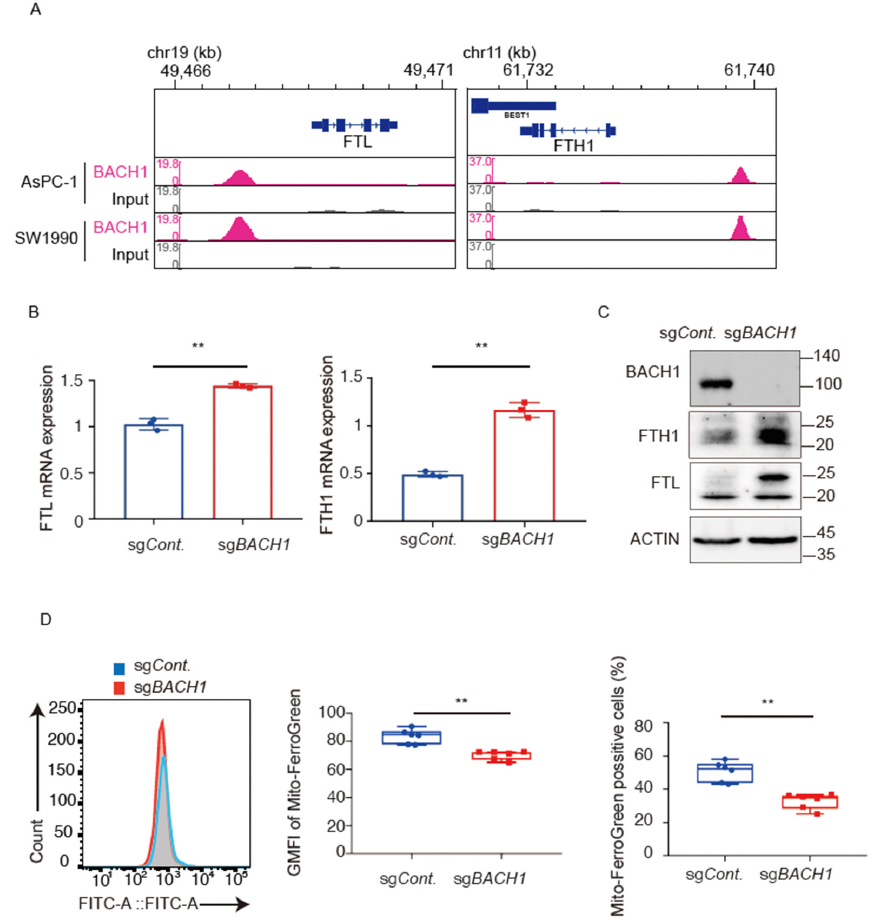
Figure 3. BACH1 increases the iron content by repressing the expression of ferritin. ( A ), ChIP-seq analysis of the binding of BACH1 to FTL and FTH1 genes in AsPC − 1 cells and SW1990 cells. ( B ), Relative mRNA levels of FTL and FTH1 in BACH1 knockout and control AsPC − 1 cells. All data are presented as mean ± SD, with p values from the Student’s t -test, n = 3 biologic replicates for each experiment. **, p < 0.01. ( C ), Western blotting of BACH1 and ferritin proteins as in ( B ). Cell lysates were used for anti-BACH1, anti-ferritin heavy, anti-ferritin light and anti-actin Western blotting. ( D ), Flow cytometry analysis for detecting mitochondrial Fe 2+ with Mito-FerroGreen in BACH1 knockout and control AsPC − 1 cells. Distribution (left), mean fluorescence intensity (middle) and the fraction of positive cells (right) are shown. GMFI, geometric mean fluorescent intensity. All data are presented as mean ± SD, with P values from the Student’s t -test. n = 3 biologic replicates for each experiment. **, p < 0.01.